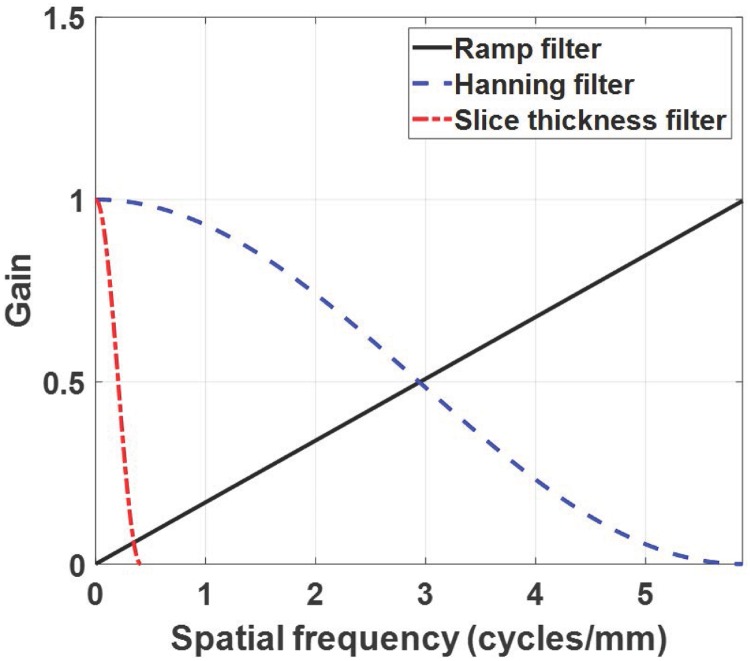
Profiles of the reconstruction filters.